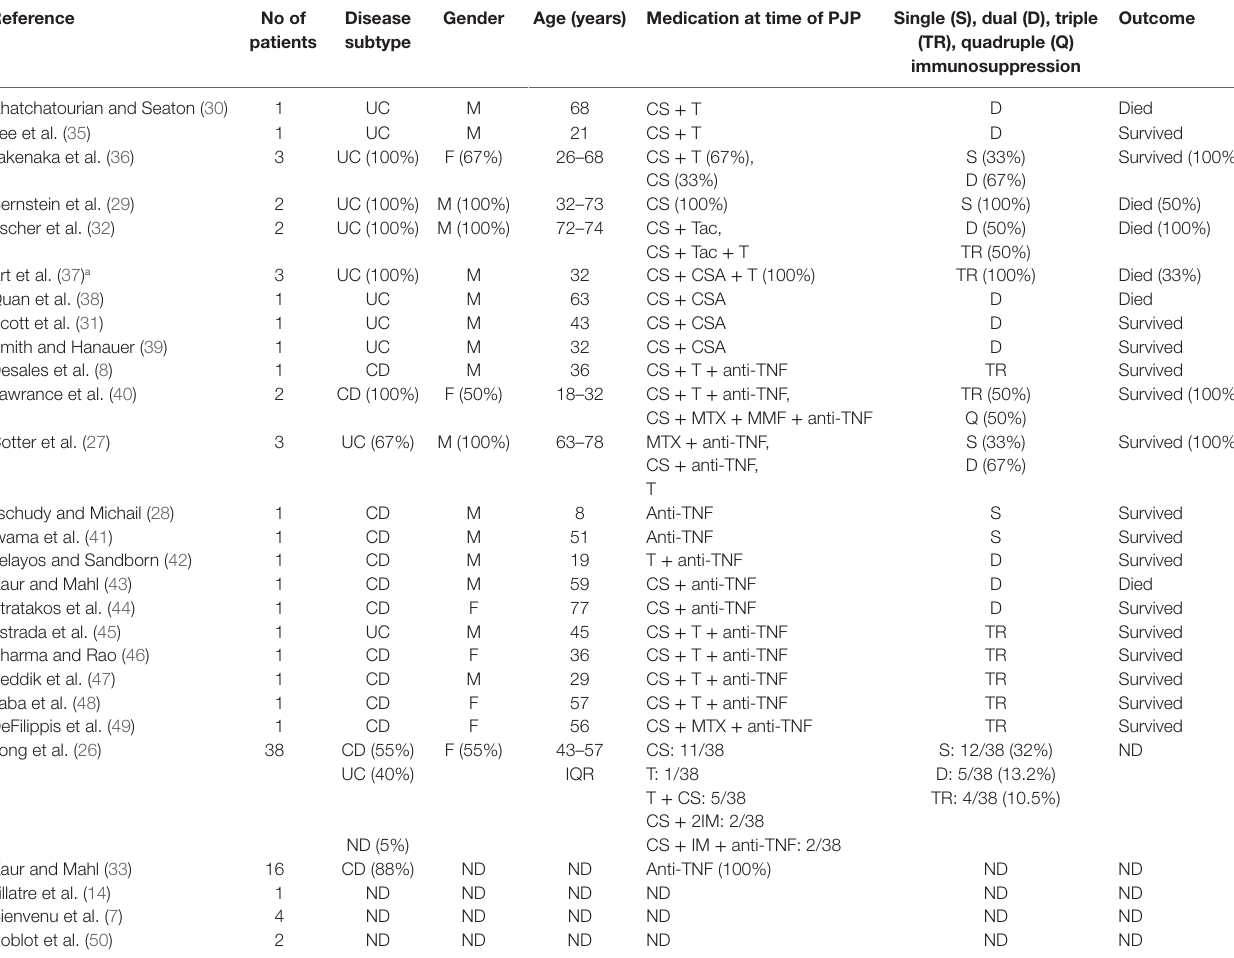
taBLe 1 | Summary of published literature of inflammatory bowel disease patients who developed pneumocystis pneumonia ( n = 92).